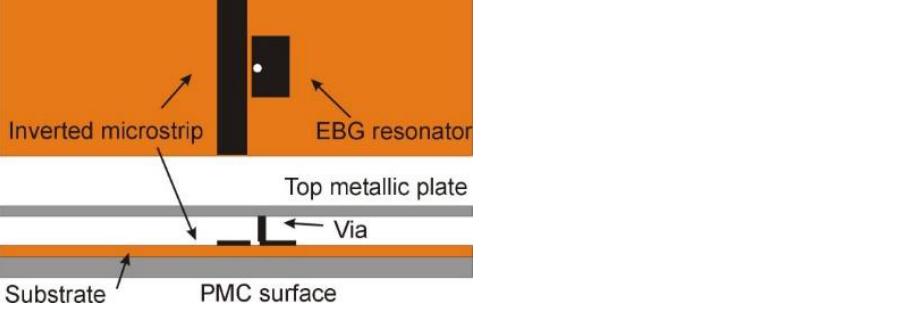
Figure 2. Periodic cell for the bed of nails and calculated dispersion diagram for the array of pins.